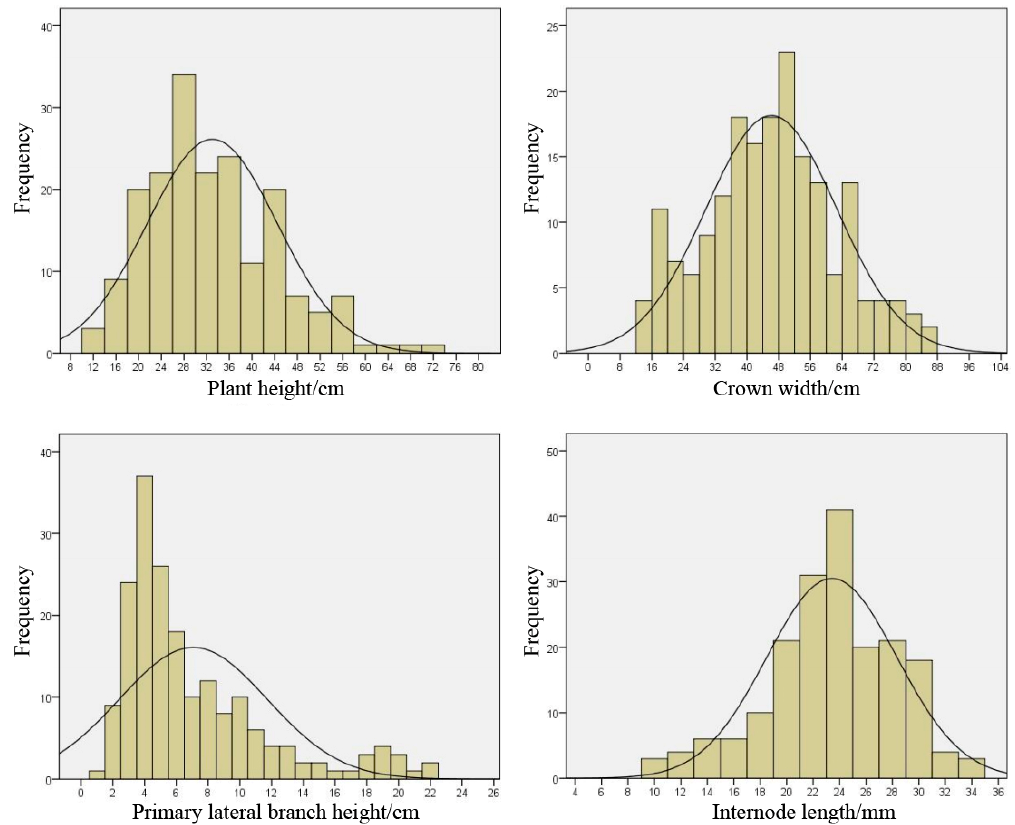
Figure 1. Frequency distribution of plant height, crown width, primary lateral branch height and internode length.